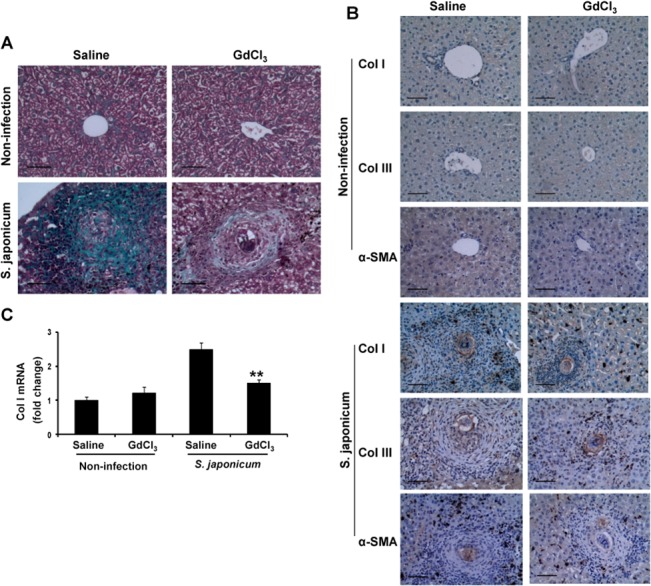
Repeated injection of GdCl3 reduced egg-induced hepatic fibrogenesis.Liver sections of saline-treated mice (control, left column) or GdCl3-treated mice (right column) were used for Masson trichrome staining for collagen deposition (A). Immunohistochemical staining was performed for collagen I (top row), collagen III (middle row), α-SMA (bottom row) (B). Collagen I mRNA in livers tissue was measured by real-time PCR (C). **
P<0.01, vs infected mice treated with saline. Original magnification ×200,bar scale 50 μm.